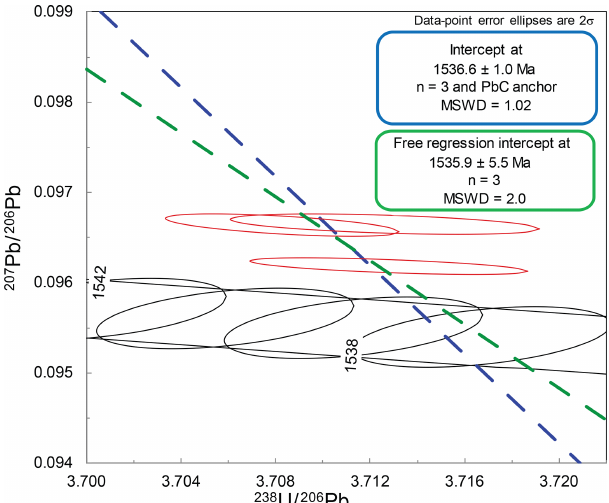
Figure 4. T–W plot of SPG-IV cassiterite showing lower intercept dates for freely regressed data (green line) and regression anchored to the Pbc 207 Pb / 206 Pb of galena analyses from the ore system (blue